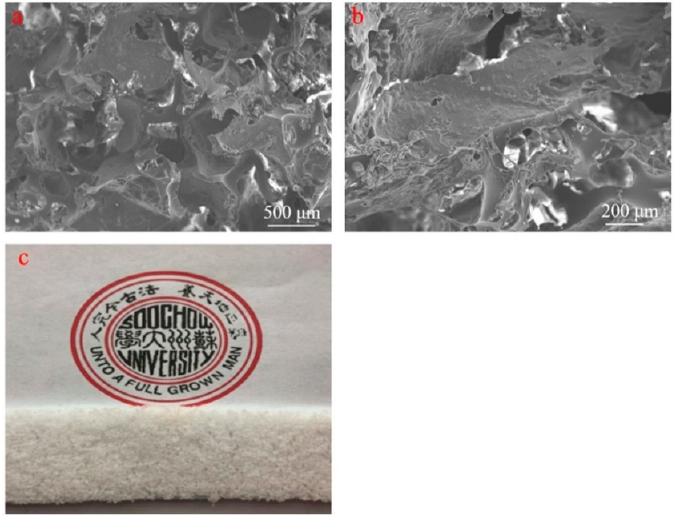
Figure 2. ( a ) SEM image showing the surface of the PDMS sponge (scale bar: 500 µm), ( b ) higher magnification SEM image of the PDMS sponge (scale bar: 200 µm), ( c ) photographic image of ~5 mm thick PDMS sponge. thick PDMS sponge.